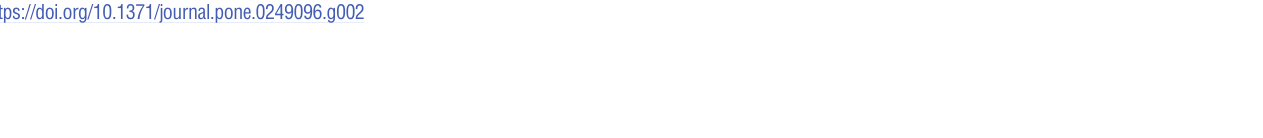
PLOS ONE | https://doi.org/10.1371/journal.pone.0249096 March 29,